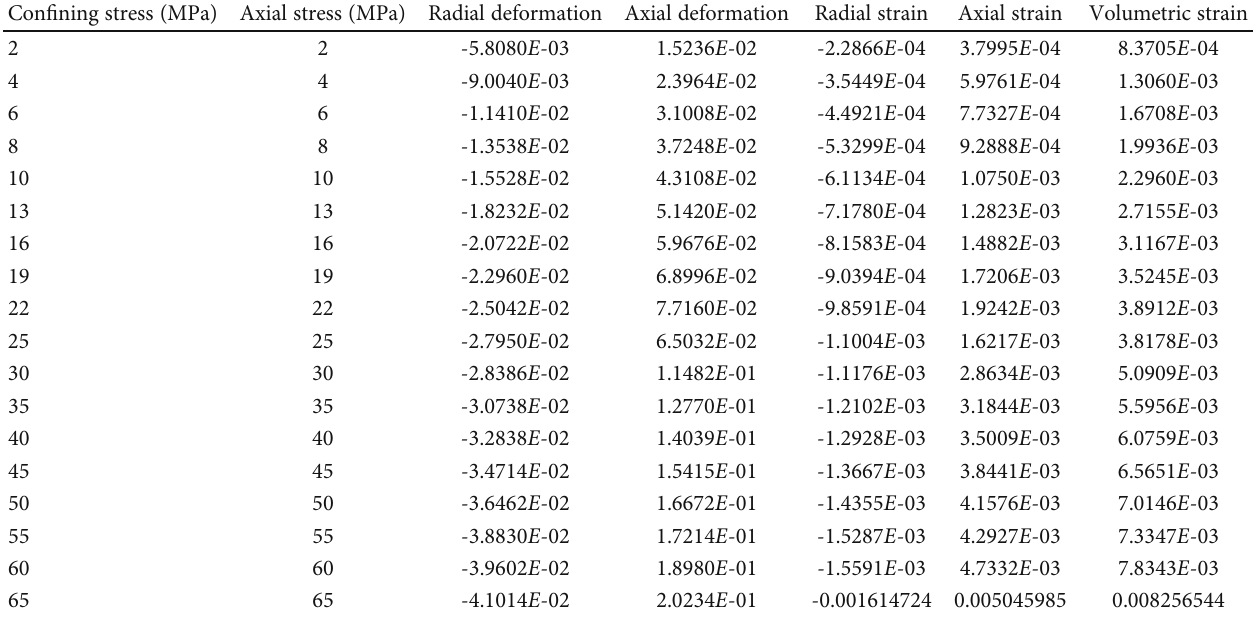
Table 2: Data of deformation and volumetric strain under di ff erent axial stress.